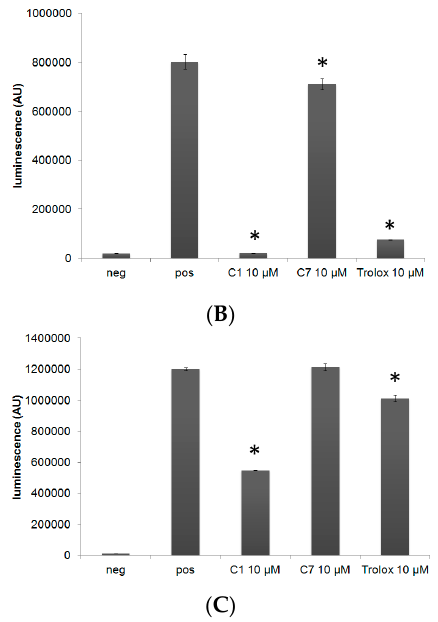
Figure 2. ( A ) Representative curve of H 2 O 2 generation as detected by chemiluminesence over 2 h by MNC. Reduction of H 2 O 2 by C1, C7, and Trolox in ( B ) MNC and ( C ) PMNC, * indicates p < 0.05 reduction compared to positive control. Values expressed as mean ± standard deviation.